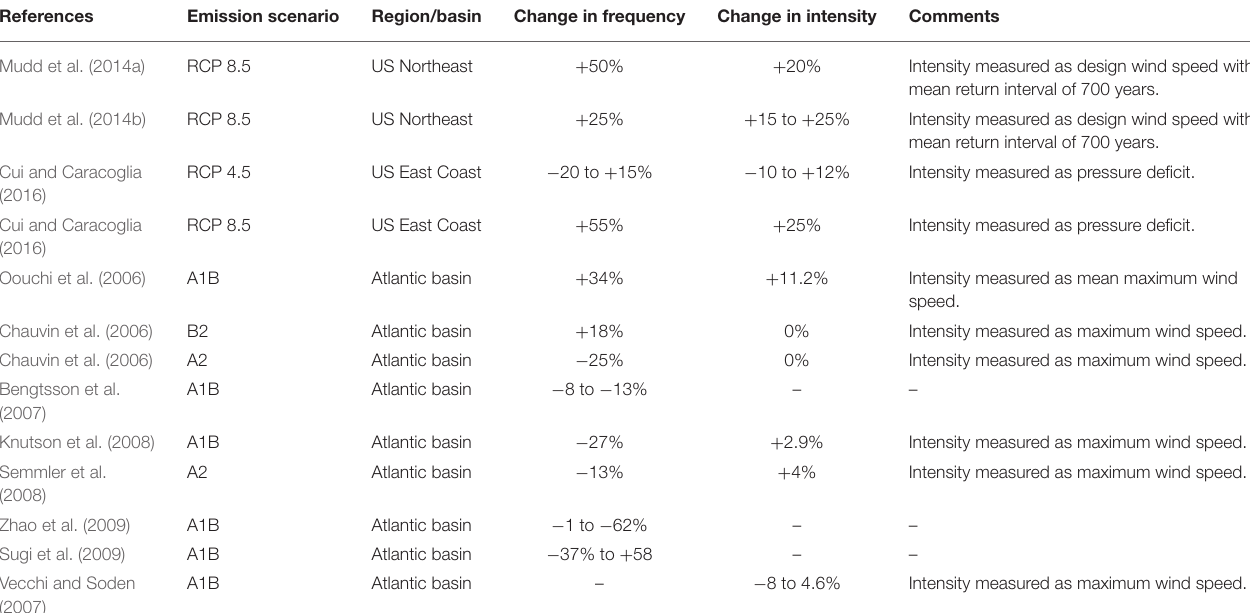
TABLE 1 | Summary of research on the impact of climate change on hurricane frequency and intensity (only research that provides numerical values under specific emission scenarios are